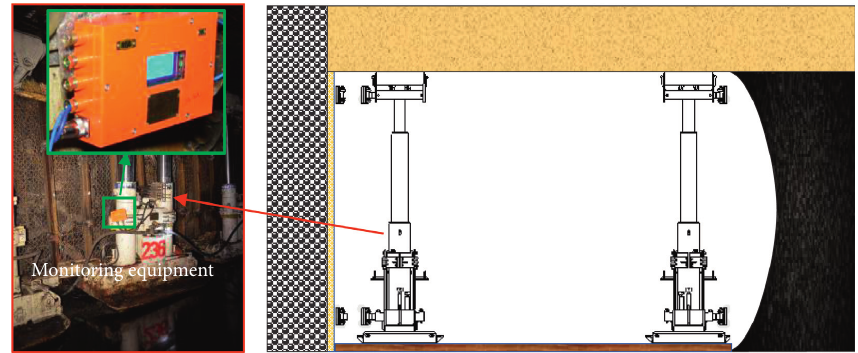
Figure 15: Monitoring method of dynamic pressure bearing